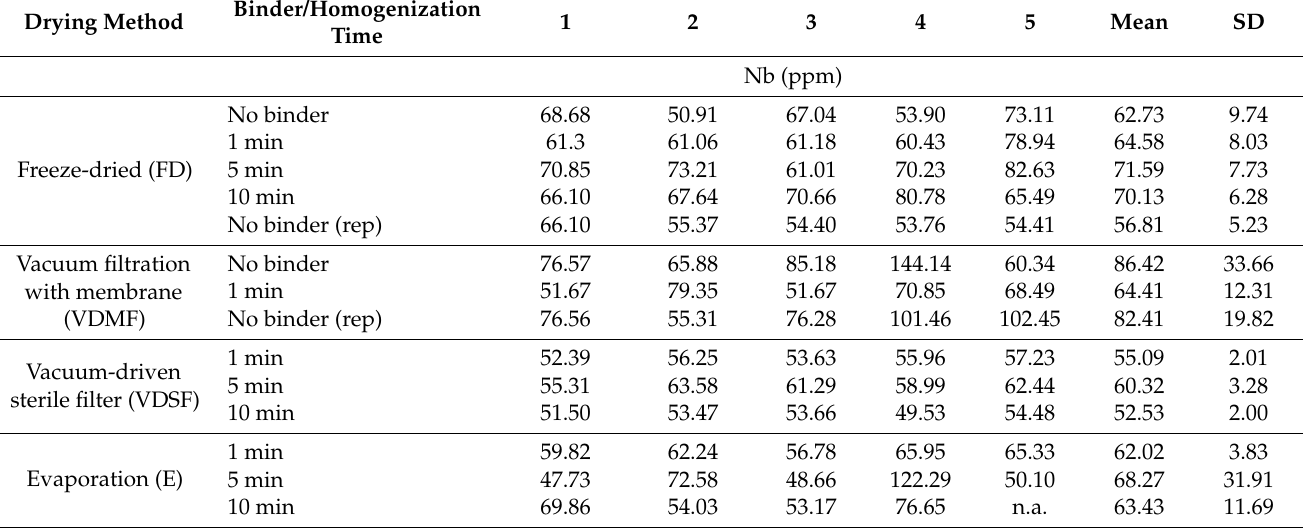
Table 5. Summary of the Nb concentrations (ppm) of the Penouta ore pellets obtained by LA-ICP- MS spot analysis following pellet production using different drying techniques. The values are based on data normalized to SiO 2 as an internal standard. SD = standard deviation; rep = repeated analytical run.